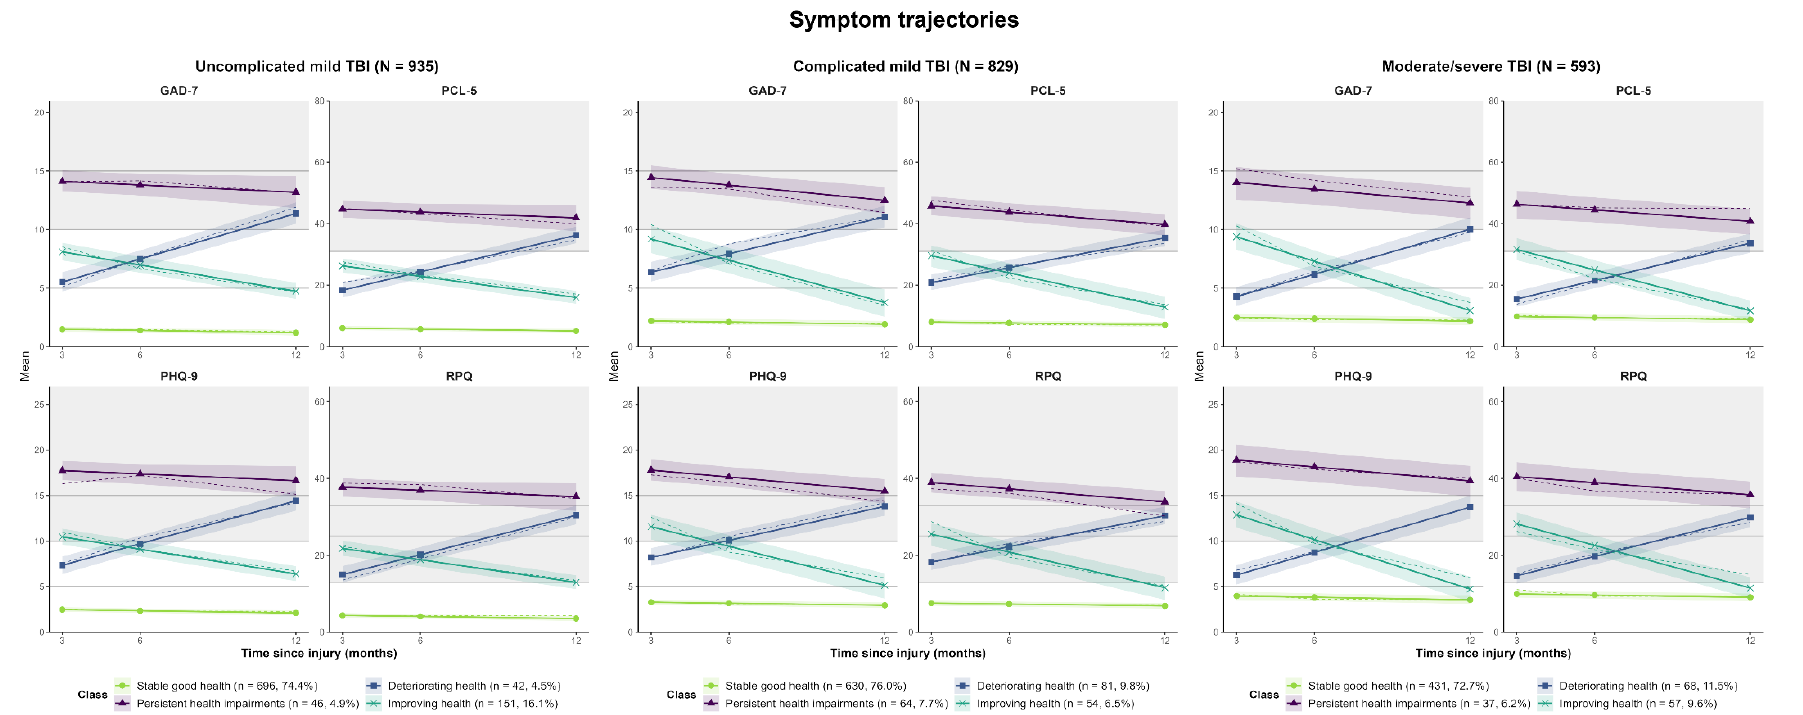
Figure A2. Symptom trajectories (GAD-7, PHQ-9, PCL-5 and RPQ) for the best solutions of model 1 (random intercept, fixed slope) for subgroups with different TBI severity. Solid, colored lines indicate predicted trajectories, dashed lines the observed values. Shaded areas around lines indicate 95% confidence intervals for predicted values. Gray lines mark cut-off values for categorical classification of outcomes (GAD-7: 5 = mild, 10 = moderate, 15 = severe; PHQ-9: 5 = mild, 10 = moderate, 15 = severe; RPQ: 13 = mild, 25 = moderate, 33 = severe; PCL-5 ≥ 31: PTBS screening). Gray areas mark values above the cut-offs for clinical relevance (GAD-7 ≥ 10; PHQ-9 ≥ 10; PCL-5 ≥ 31; RPQ ≥ 13).